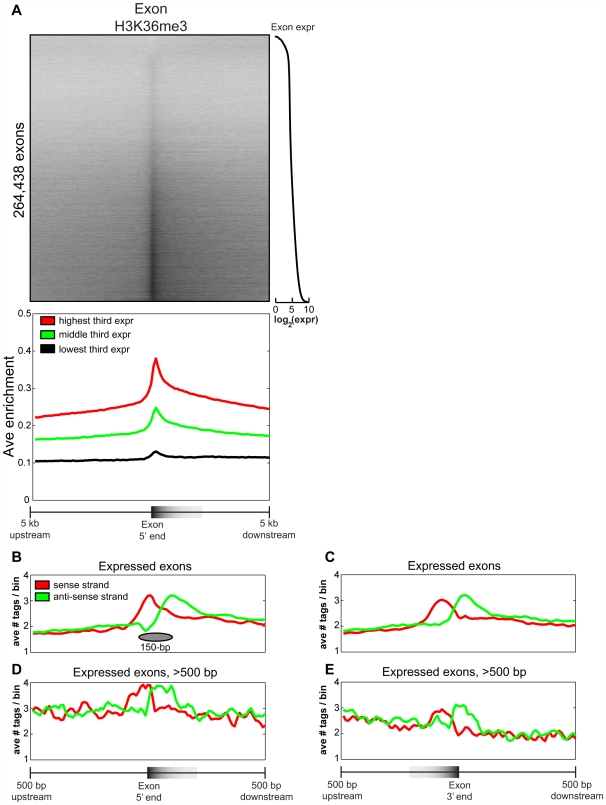
H3K36me3 marks exon 5′ ends and is a global mark of
expression.(A) The top panel is a heat map of H3K36me3 enrichment at all human
exons, sorted by exonic expression (right). The bottom panel is the
average H3K36me3 enrichment profile of the lowest, middle, and highest
third of expressed exons from the top panel. The distribution of
H3K36me3 reads within ±500 bp of exon (B) 5′ ends
and (C) 3′ ends of the top 50% expressed exons in
the human genome. In red are reads on the sense strand in the direction
of transcription, and in green are anti-sense reads. A schematic of a
positioned a nucleosome is shown. (D–E) As in (B–C),
but focusing on expressed exons longer than 500 bp.